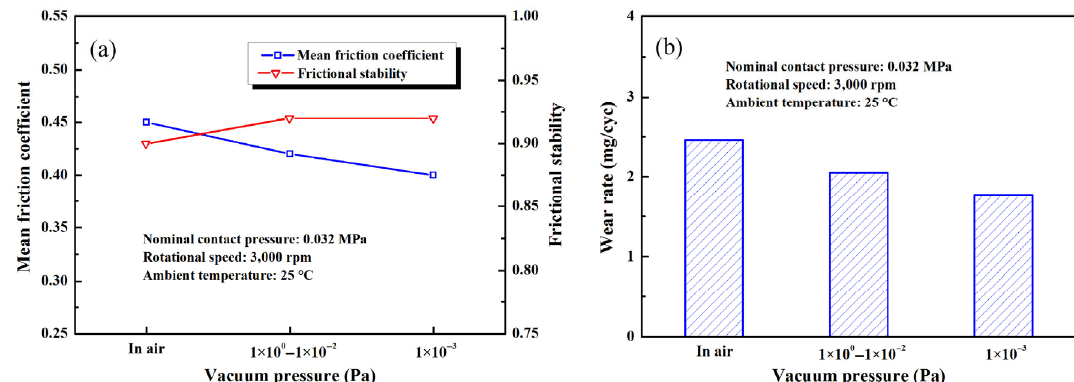
Fig. 6 Variations of (a) μ mean and FS, and (b) wear rate with vacuum